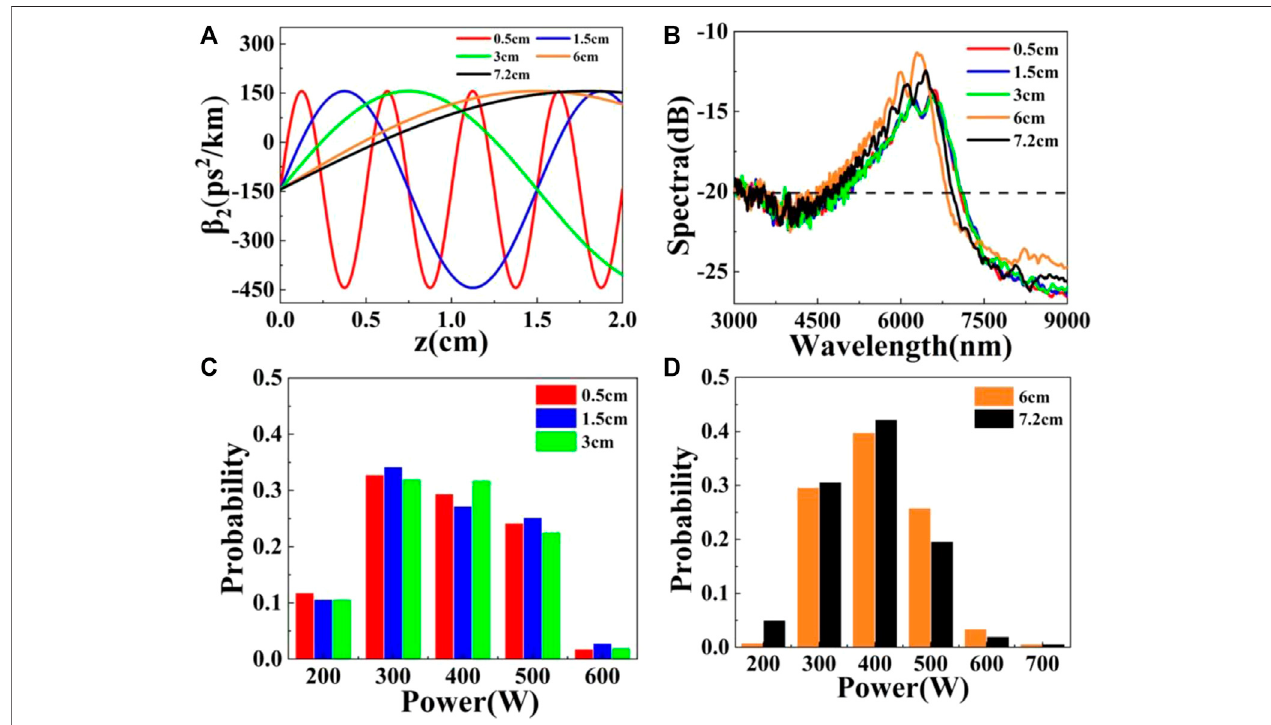
FIGURE 6 | (A) Dispersion curves, (B) output mean spectra, (C,D) histograms of the peak power beyond 7,000 nm of the output spectra in DOF with different oscillation periods (